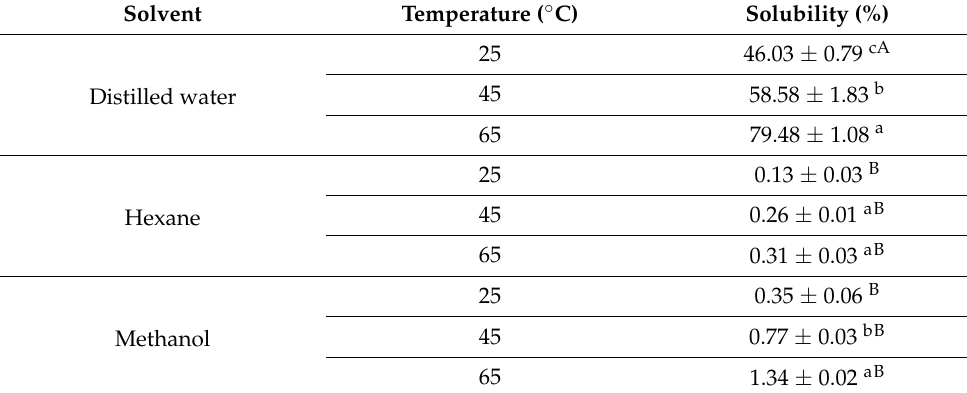
Table 3. Solubility of the mucilage from Corchorus olitorius